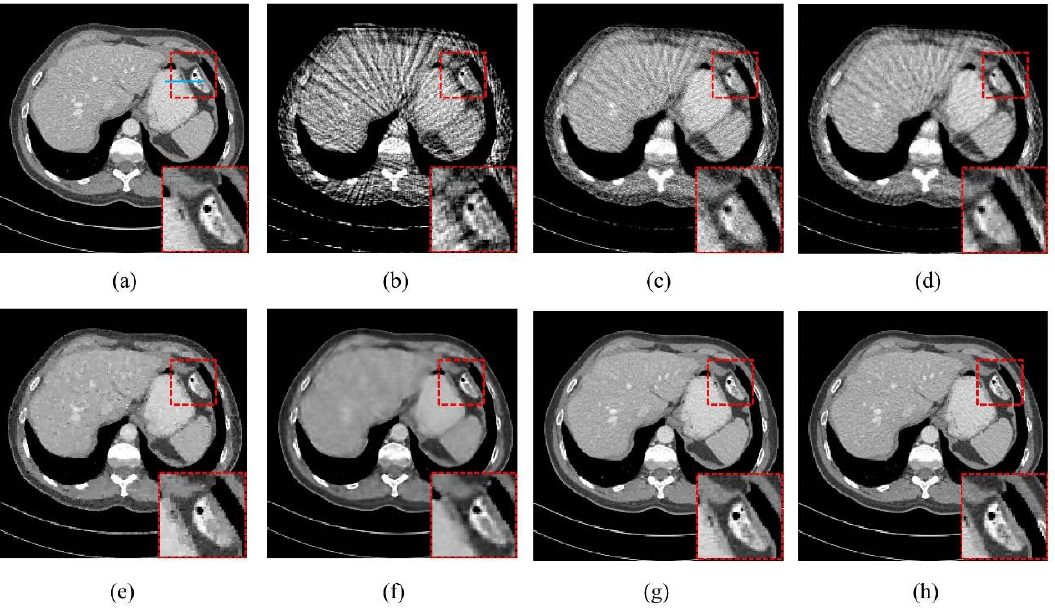
Figure 5. Images reconstructed (from 64 views) using various methods. ( a ) The reference image versus the images reconstructed using ( b ) FBP, ( c ) ART, ( d ) ART-TV, ( e ) TVAL3, ( f ) FBPConvNet, ( g ) LEARN, and ( h ) our network. The profiles along the blue line are shown in Figure 6. The red box indicates the ROI, which is magnified. The display window is [0, 1100] HUs in size.